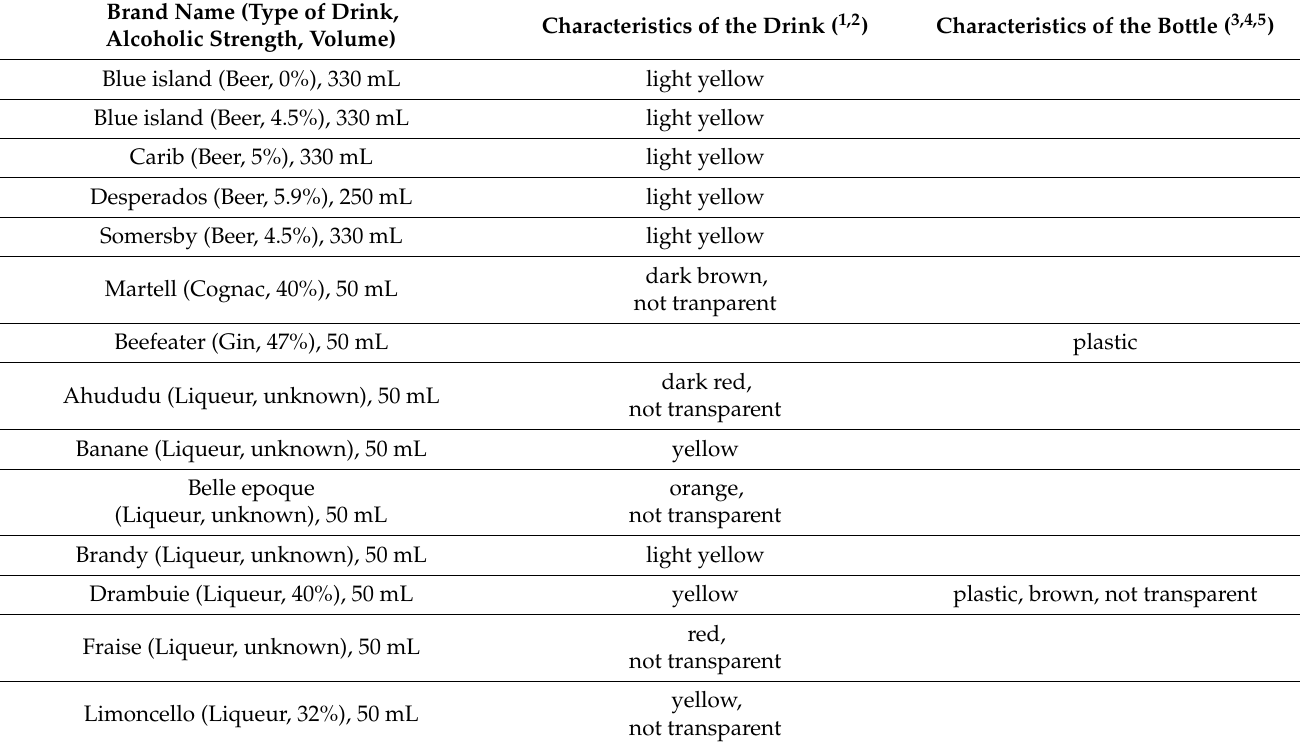
Table 1. Drinks (brand name, type, volume of the container) used for the study. The alcohol content (strength), color, and as information about the container are